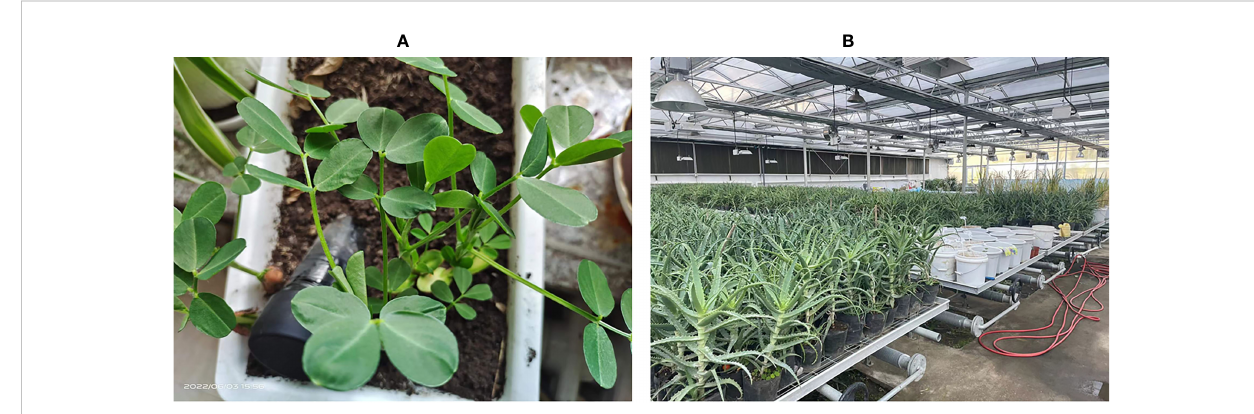
FIGURE 2 Experimental scenario. (A) Minirhizotron installation, (B) Greenhouse